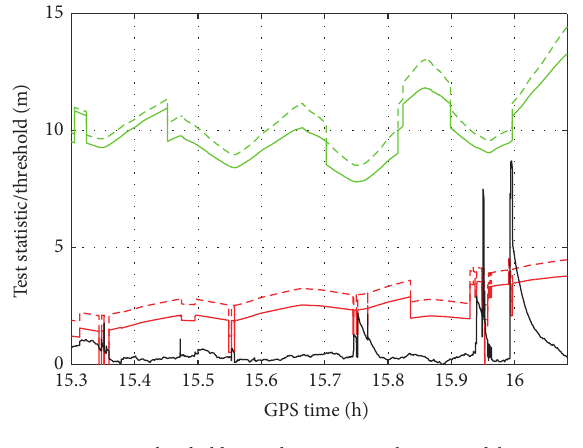
Monitoring threshold L1 with experimental noise models Monitoring threshold L1 with realistic noise models Monitoring threshold L1 with experimental noise models full const. Monitoring threshold L1 with realistic noise models full const. Figure 8: Monitoring thresholds for the case of two affected satel- lites with the constellation as seen during the flight trials (red) and simulated full GPS + Galileo constellation (green).